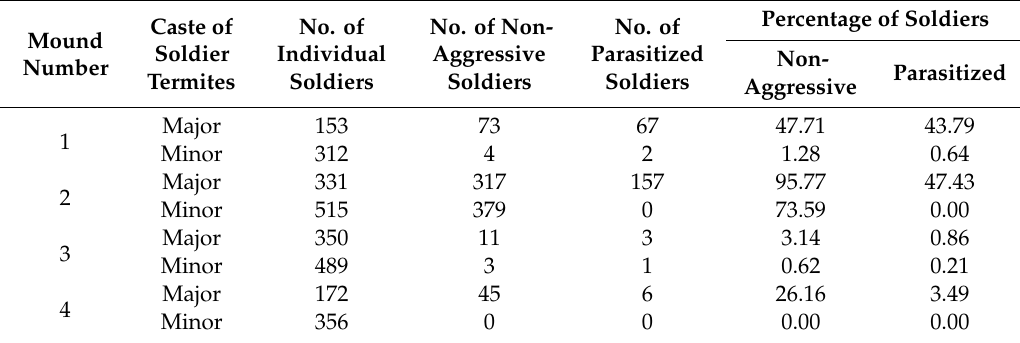
Table 1. Numbers and percentages of major and minor soldiers in four Macrotermes gilvus mounds that were (a) non-aggressive, and (b) both non-aggressive and